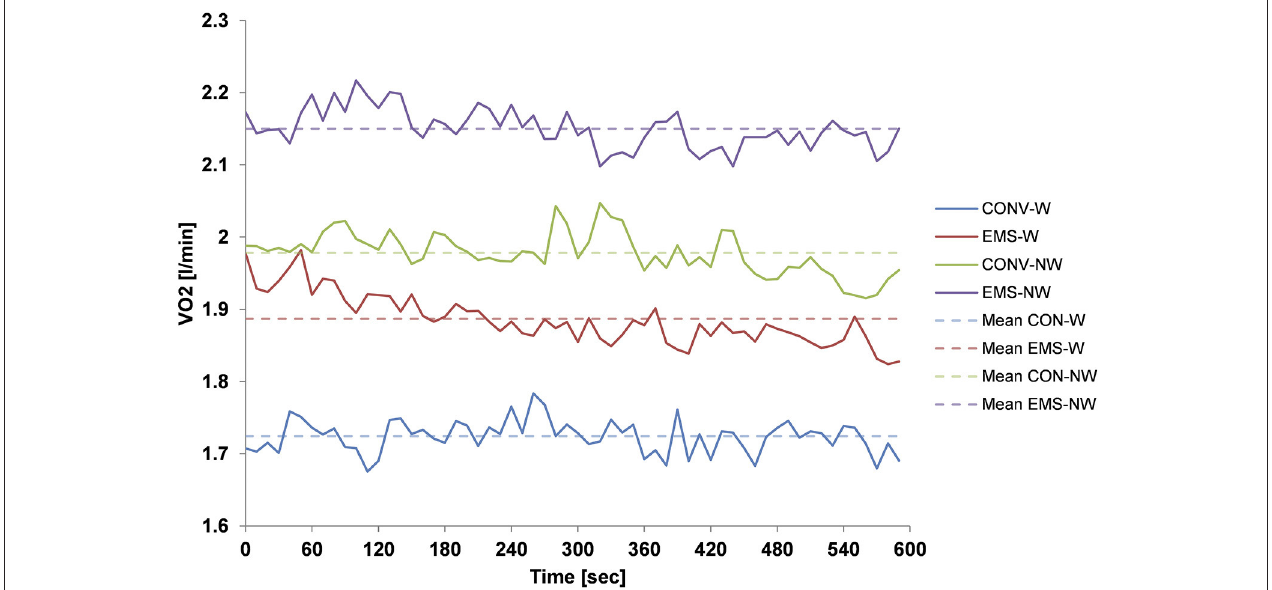
FIGURE 2 | VO 2 uptake during a 10min treadmill test for the four different test situations: blue line indicates conventional walking (CON-W); red line indicates electrical muscle stimulation (EMS)-superimposed walking (EMS-W); green line indicates conventional Nordic walking (CON-NW); and the purple line indicates EMS-superimposed Nordic walking (EMS-NW). The solid line represents the mean on 10s intervals for all subjects and the dashed line represents the mean value for all subjects over the 10min measurement time. Solid shows continue steady progress in VO 2 uptake for all measurement conditions with overlaps between two measurement conditions indicating differences in VO 2 uptake between them. Differences in dashed lines support these results.